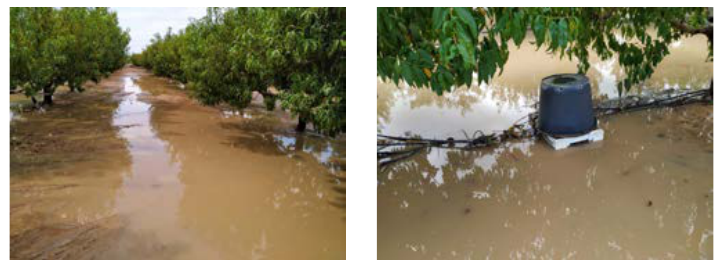
Figure 11. The flooding in the experimental nectarine orchard two days after the DANA